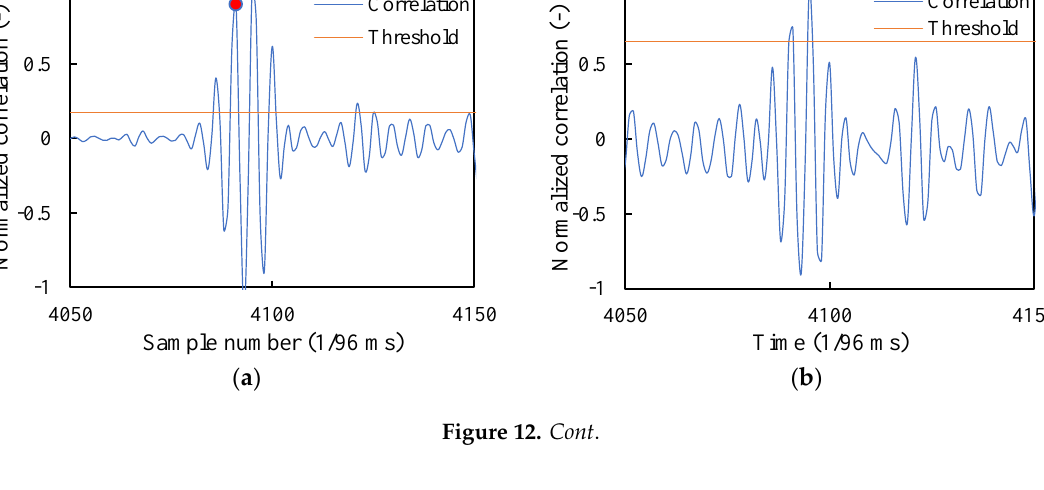
Figure 11. Positioning error.